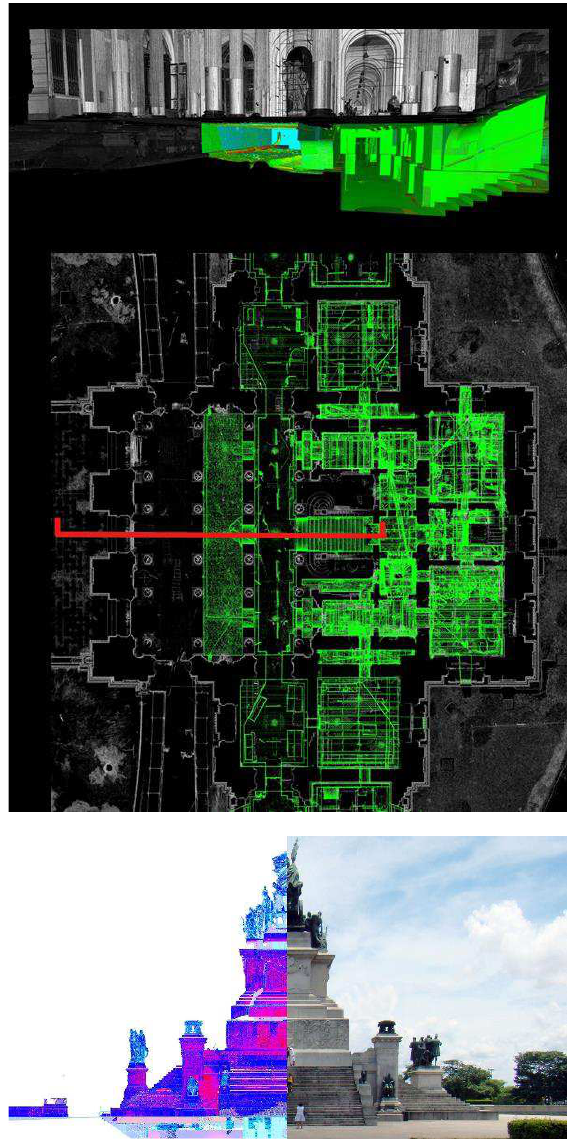
Figure 11. 3D points cloud processing and analysis. Variety of uses of Digital Elevation Models, DEM: from state of the art documentation and analysis for the restauration project toward 3D point cloud comparison with the photographic survey of Monumento à Independência do Brasil in order to develop non-conventional representation for both experienced and inexperienced end